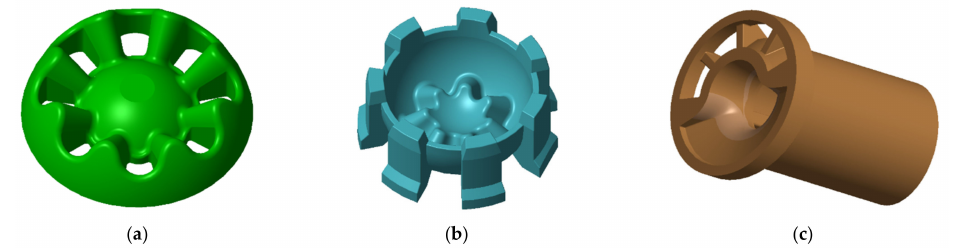
Figure 2. Rotor ( a ), stator ( b ) and hollow shaft ( c ) of the TMC pump. Within one hollow shaft rotation, the rotor tumbles one tooth further inside the stator. The increasing and decreasing fluid volumes between rotor and stator push and pull fluid through the channels in the rotor, similar to an axial piston pump. The slanting plate acts as a valve plate and separates suction and delivery port. Further details of this pump’s function can be found in the work of Munih et al.